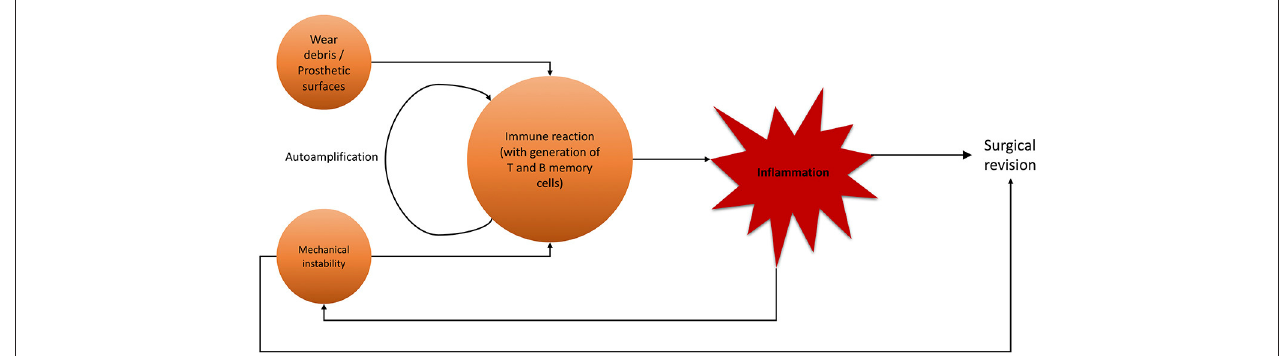
FIGURE 7 | Flowchart of noxae promoting aseptic hip implant loosening and subsequent surgical revision. Wear debris and mechanical instability are major agents for inflammatory immune reaction, not limited to lymphocytes.